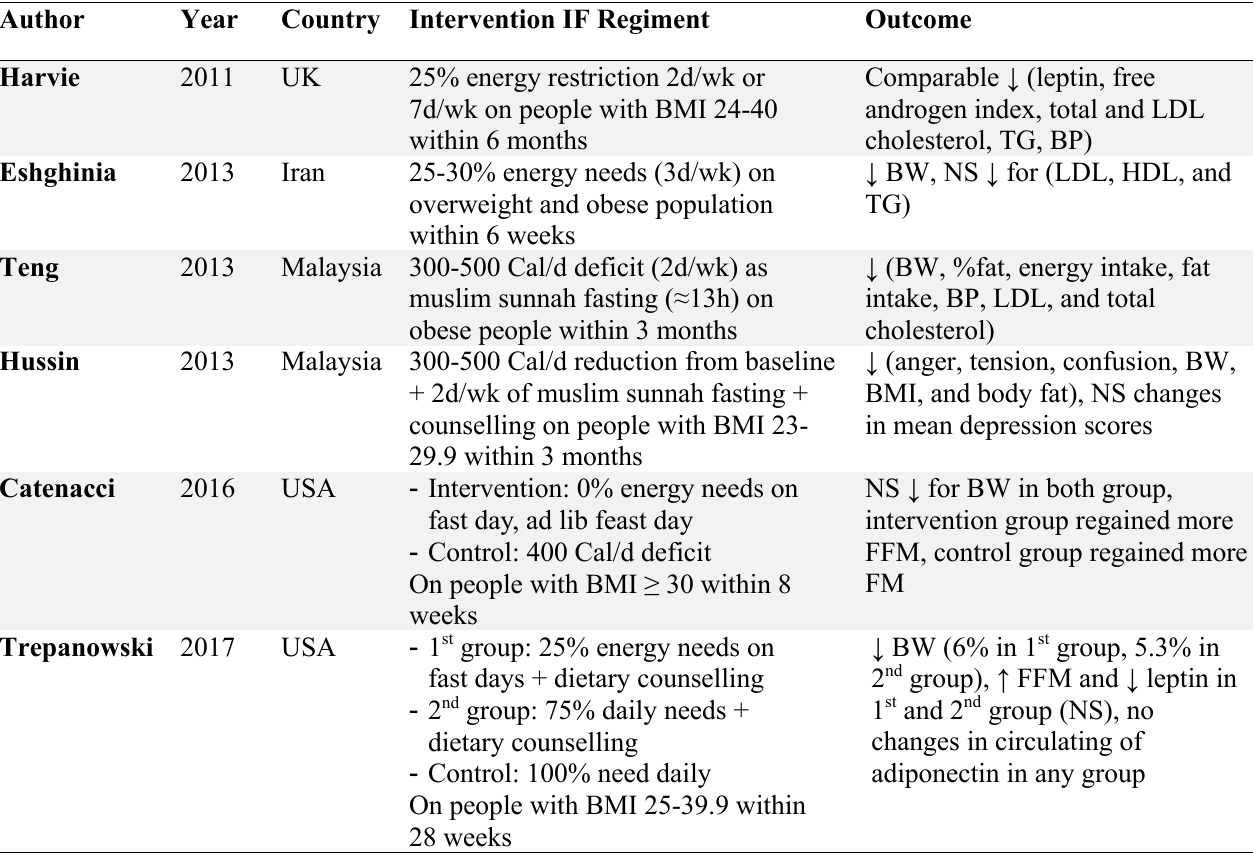
Table 2 . Clinical trial studies result on IF regiments Author